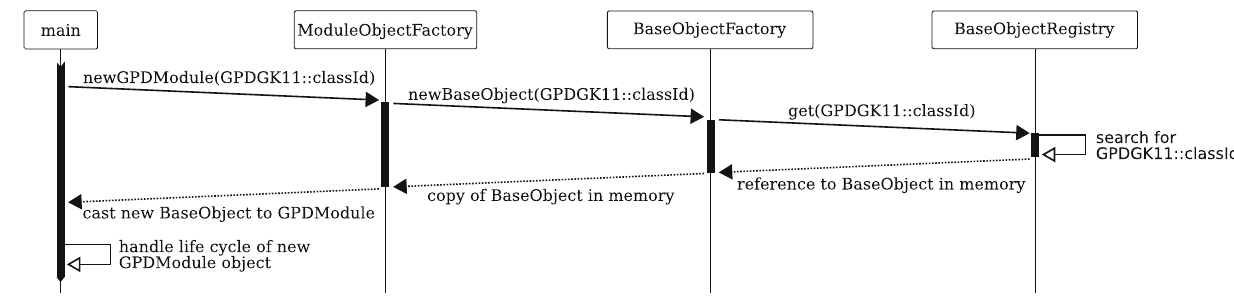
Fig. 7 Sequence diagram presenting the different processes, arranged in time, relating the different objects allowing the instantiation of a new module from the sole information of its identifier or name. See Fig. 6 for the description of diagram elements